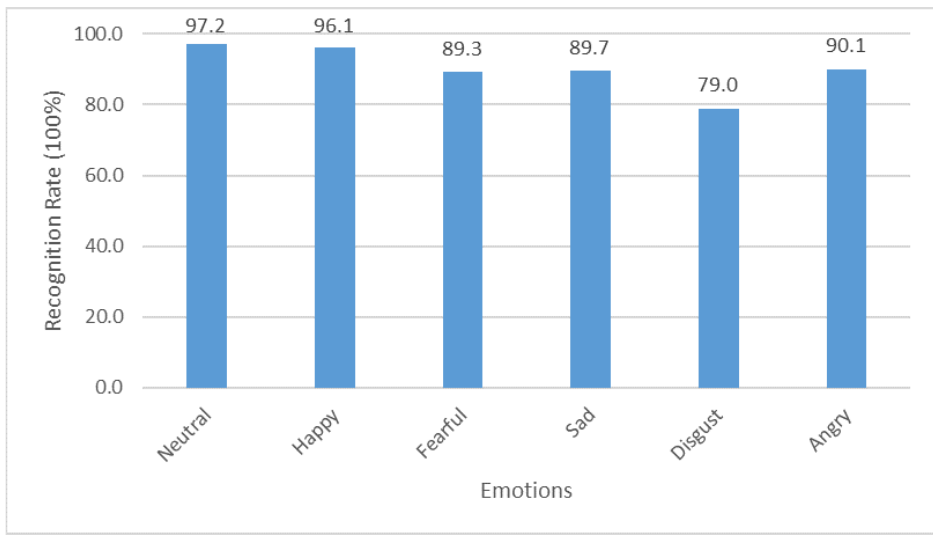
Figure 3. Emotion identification accuracy analysis of the presented system using ESD.